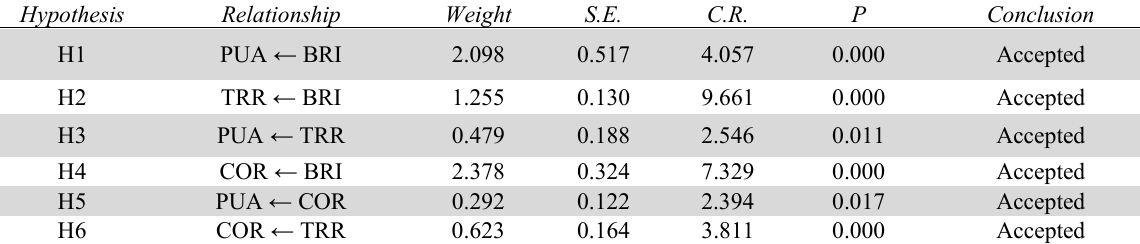
SEM analysis results for relationships in the model